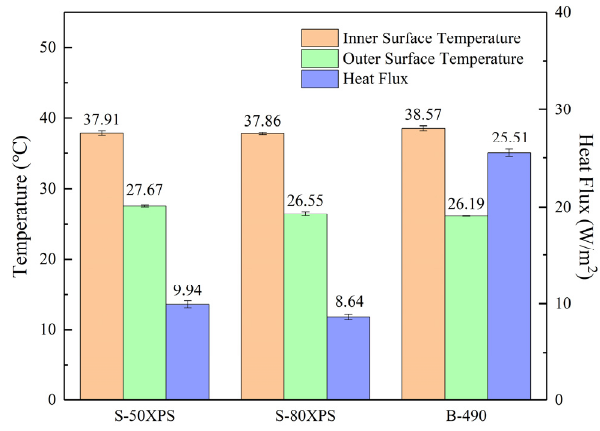
age outer surface temperature, and average heat flux from the test results.